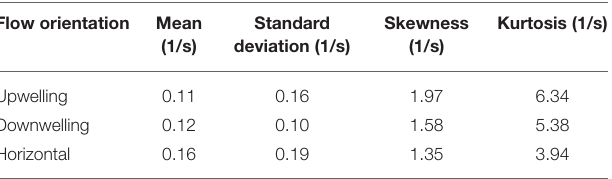
TABLE 1 | Statistics for the probability distributions of fluid vorticity eliciting consequential larval behavioral responses in different shear flow